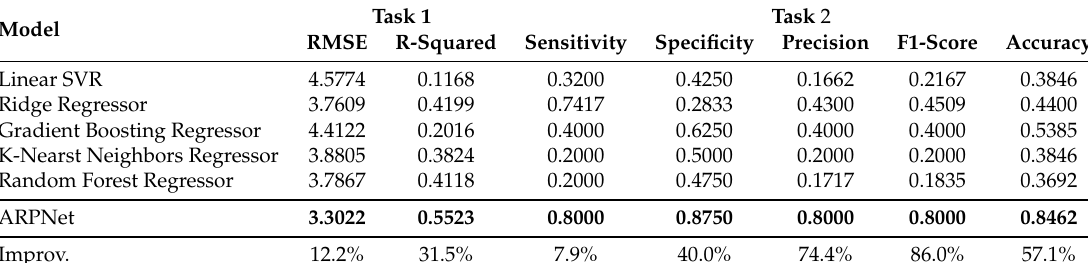
Table 5. Experimental evaluation results. The performance improvement of ARPNet over the baseline with the best performance is reported in the Improv.